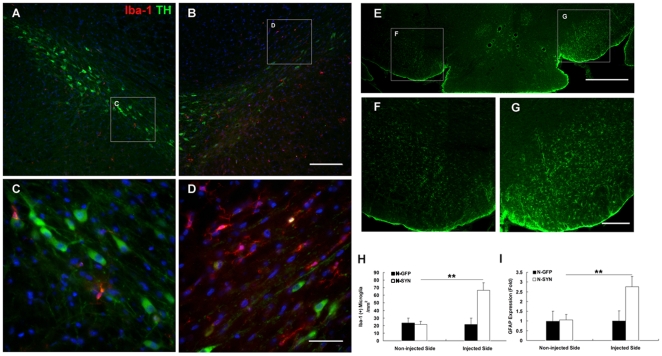
Increased microglia and astrocyte activation in the substantia nigra of rat in response to N-SYN.Coronal VM sections of N-SYN group rats showed loss of DA neurons (TH, green) concurring with mounting microglia (Iba-1, red) in substantia nigra of ipsilateral side (B) vs. that in substantia nigra of contralateral side (A). (C) and (D) representing a magnification of boxed area in (A) and (B), respectively. More microglia exhibited activated morphology were found close to atypical DA neurons on the N-SYN-injected side (B, D). Quantifications showed there were more Iba-1-positive microglia on the N-SYN-injected side (66.5±9.9/mm2) vs. those on the non-injected contralateral side (21.5±3.8/mm2, p<0.01) (H). Scale bars: (A, B), 200 µm; (C, D), 50 µm. Coronal VM sections of N-SYN group rats showed astrocyte activation (GFAP, green) in SNpc of ipsilateral side (E). (F) and (G) representing a magnification of boxed area in (E). Quantification of anti-GFAP immunostaining showed the level of GFAP expression in N-SYN group was augmented to 2.7±0.5 fold on the ipsilateral side vs. that on the contralateral side (p<0.01) (I). Scale bars: (E), 800 µm; (F, G), 200 µm. Data represent mean ± SEM from three independent experiments. **, p<0.01.